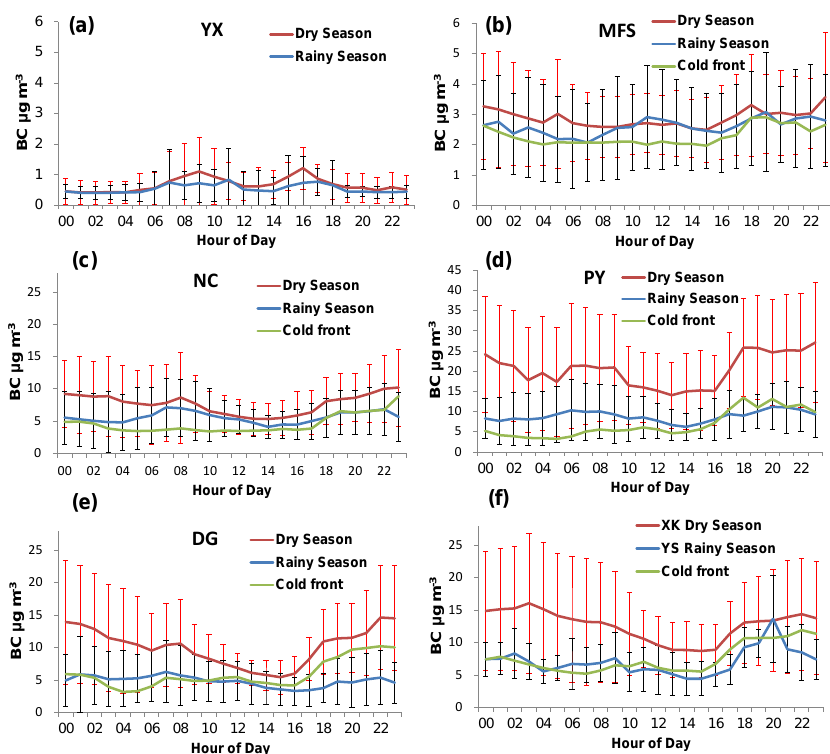
Fig. 5. Diurnal variations of BC concentrations at six monitoring sites in the rainy sampling period, dry season sampling period, and during cold front periods. The error bars represent one standard deviation. The sites are (a) Yongxing Island (YX), (b) Maofengshan (MFS), (c) Nancun (NC), (d) Panyu (PY), (e) Dongguan (DG), (f) Xinken (XK) in the dry season sampling period and Yangshuo (YS) in the rainy season sampling period.